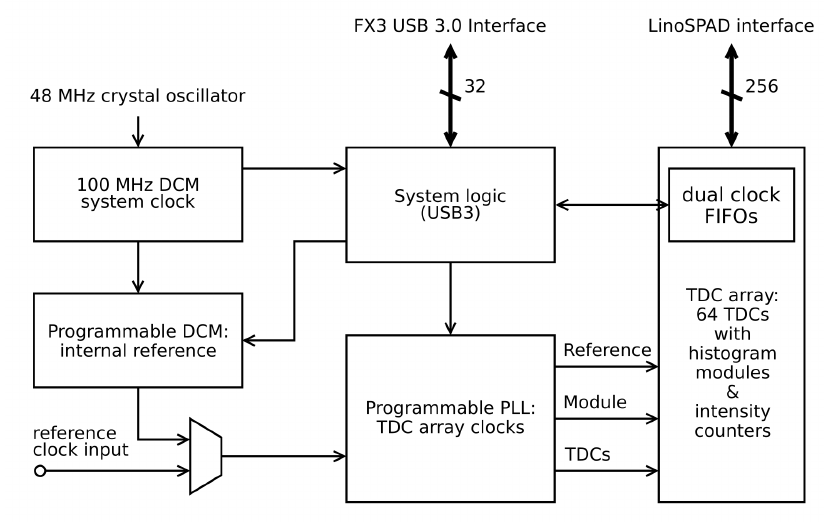
Figure 3. The LinoSPAD camera firmware is composed of two major subsystems with their state-machines controlled from a USB interface. The clock control part is responsible for generating the system clocks and synchronizing an illumination system. The time-to-digital converter (TDC) array, which contains the delay lines, histogram generation and post-processing, interfaces with the SPAD sensor and processes the pixel